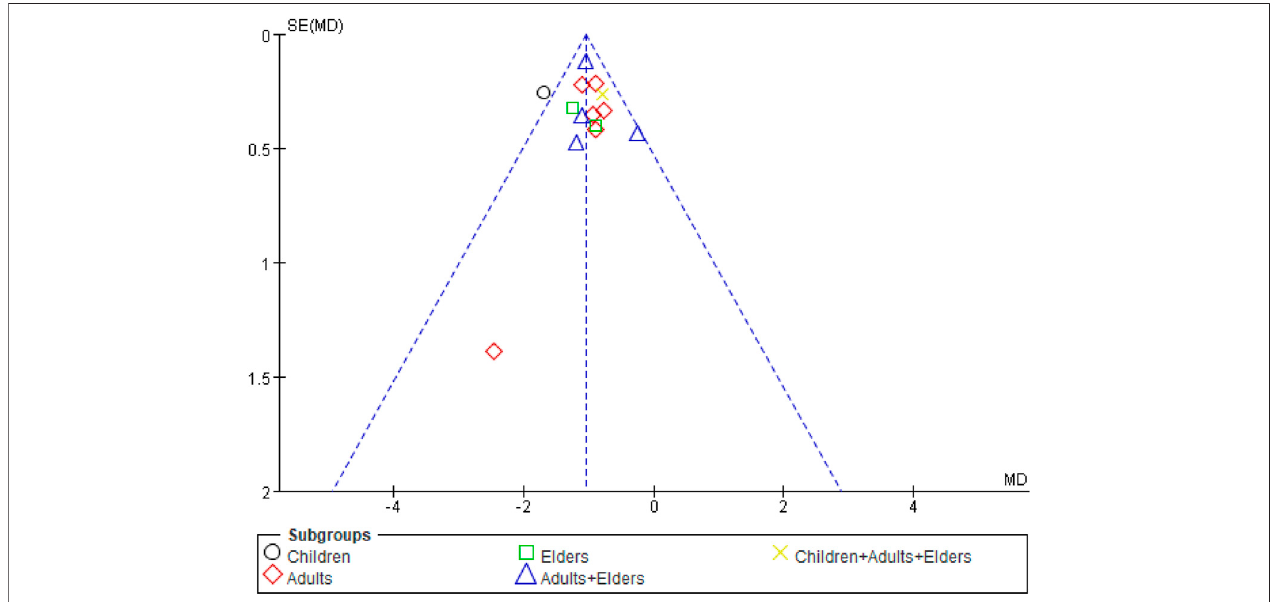
FIGURE 8 | Funnel plot of comparison: SFJD plus routine treatment vs. routine treatment, outcome: duration of cough. SFJD: Shufeng Jiedu.